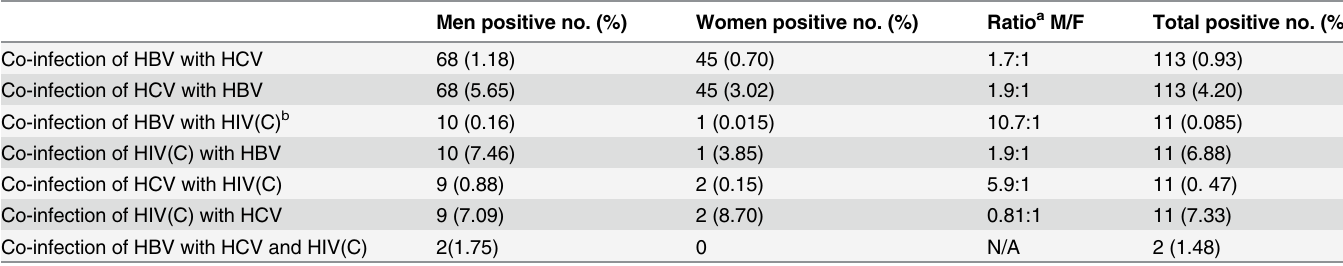
Table 3. Co-infection Rates for HBV, HCV, and HIV According to Sex. Men positive no. (%) Women positive no. (%) Ratio a M/F Total positive no. (%) Co-infection of HBV with HCV 68 (1.18) 45 (0.70) 1.7:1 113 (0.93) 68 (5.65) 45 (3.02) 1.9:1 113 (4.20) 10